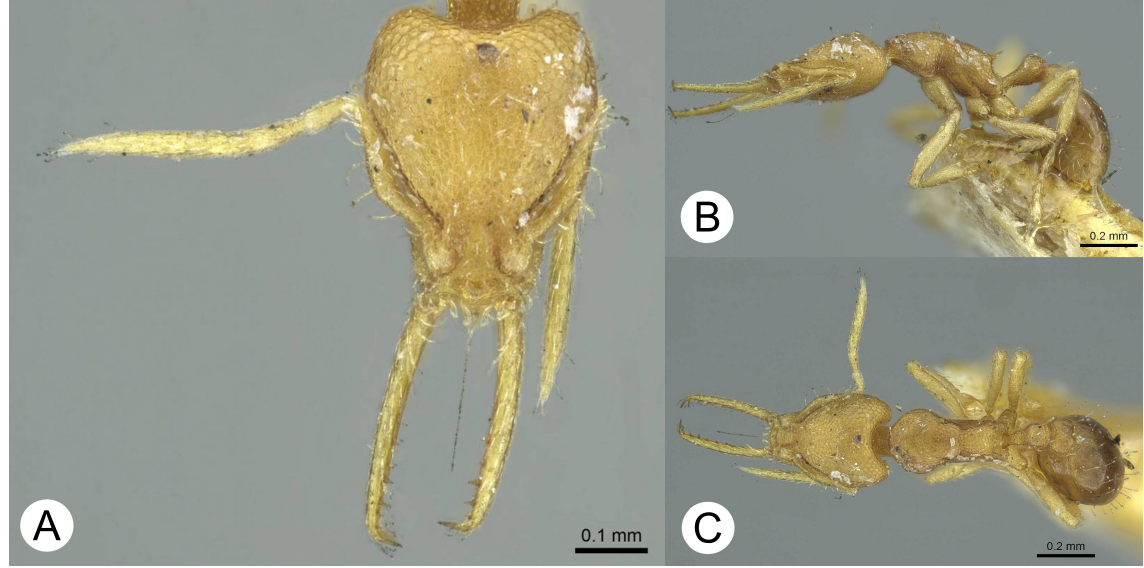
Fig. 3. Lectotype of Strumigenys denticulata Mayr, 1887 (CC-BY, CASENT0915944, Anna Pal, from www.antweb.org). A . Head, mandibles and antennae, in dorsal view. B . Full body, in lateral view. C . Full body, in dorsal